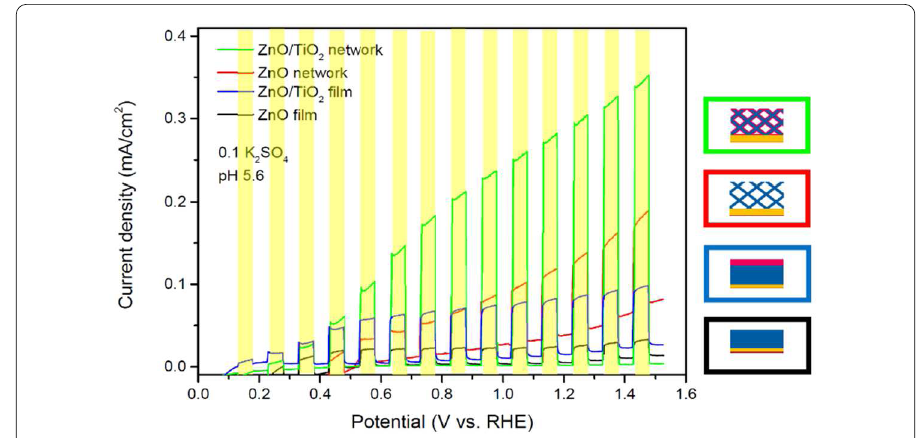
Figure 3 Measured generated photocurrents for ZnO nanowire networks and ZnO films with and without a TiO 2 protection layer during a linear bias voltage sweep. Yellow areas mark when the samples were illuminated, white areas when the light was switched off. From L. Movsesyan et al., ©Nanomaterials 8, 693